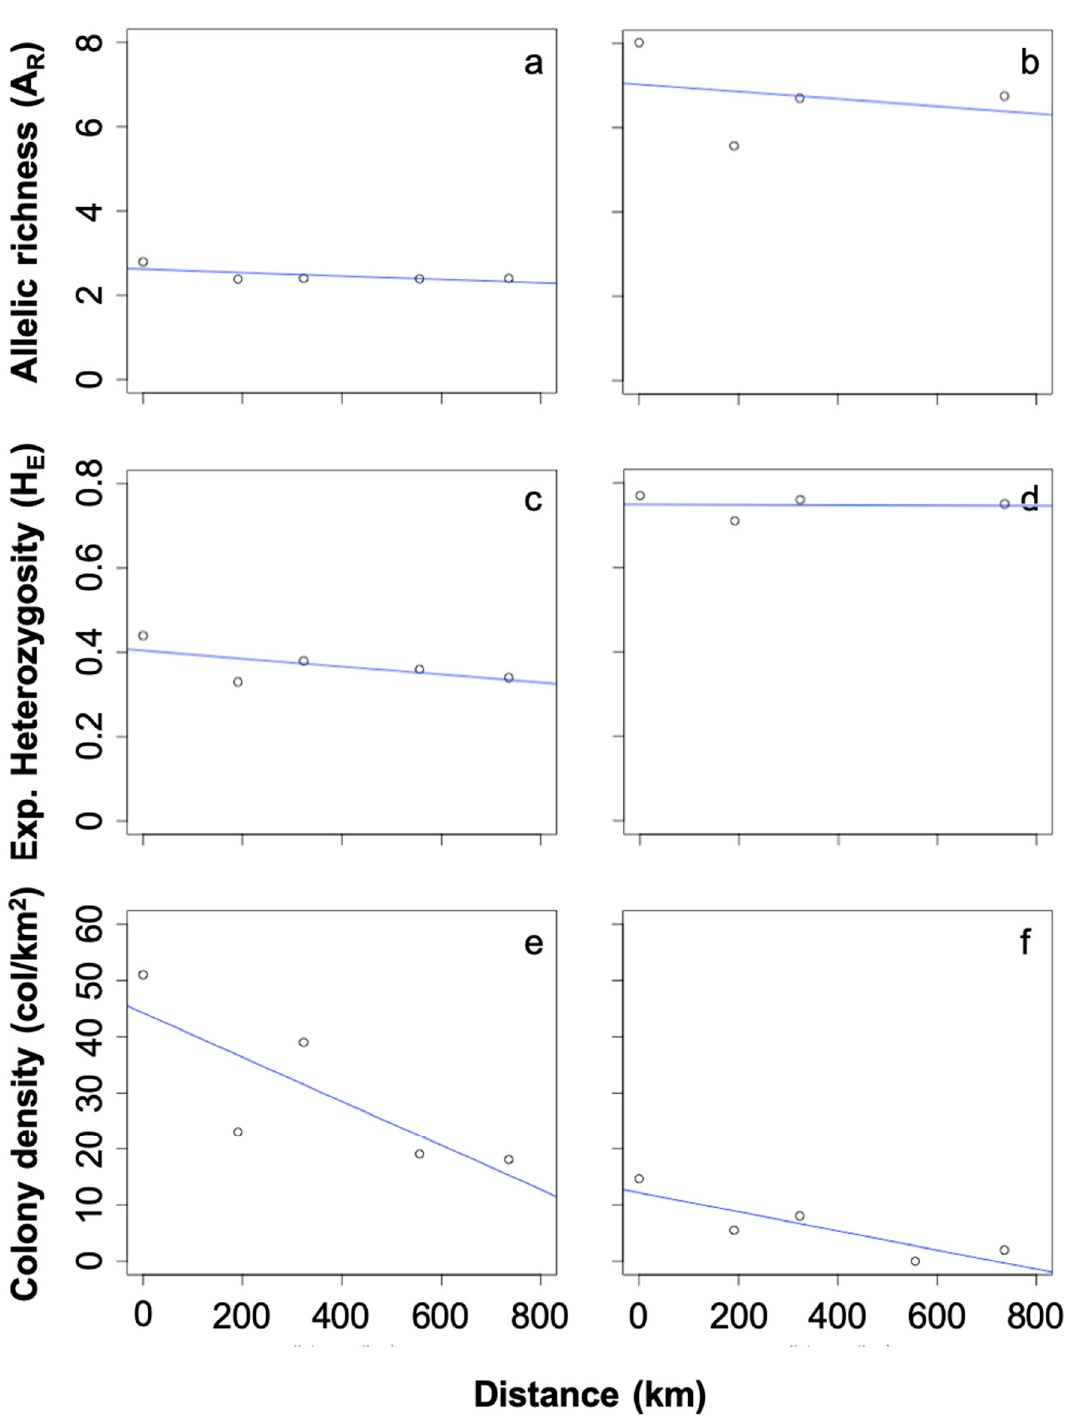
Figure 2. The decline of allelic richness ( a , b ), expected heterozygosity ( c , d ), and population density ( e , f ) from Khartoum (0 km) to Marawi (735.81 km) of both A. florea (left; a,c,e) and A. mellifera (right; b,d,f) along the river Nile.